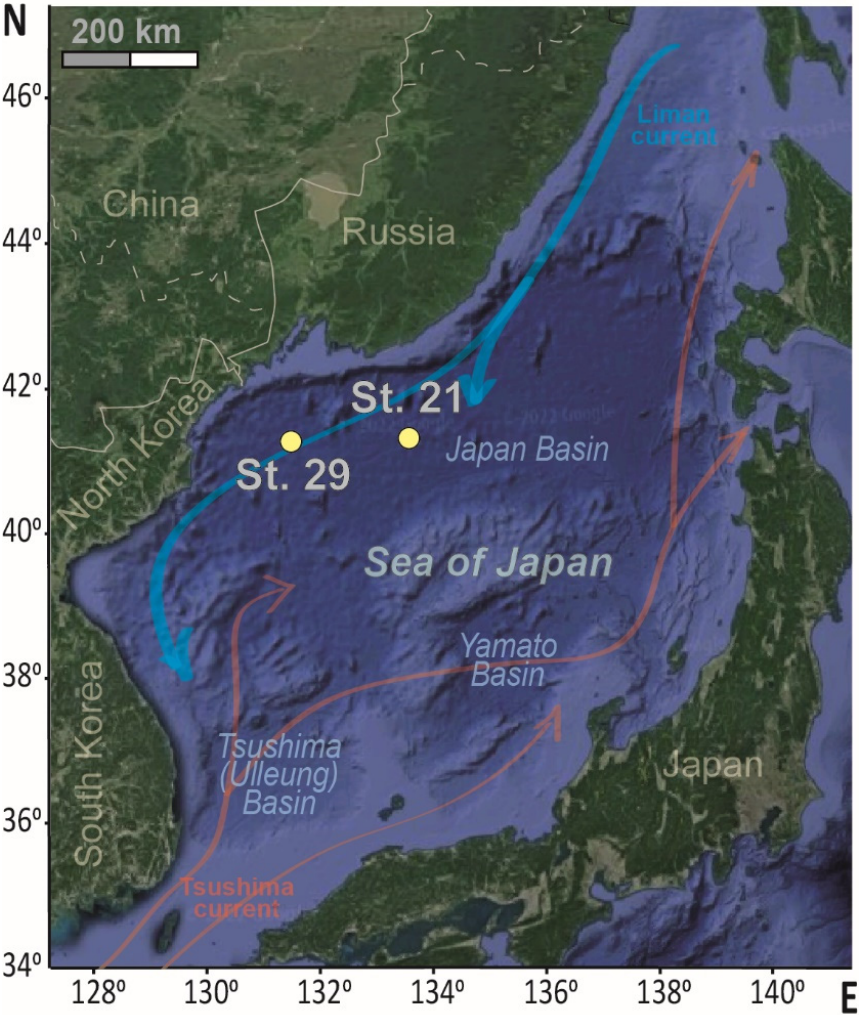
Figure 1. Location of the sampling stations in the Sea of Japan.